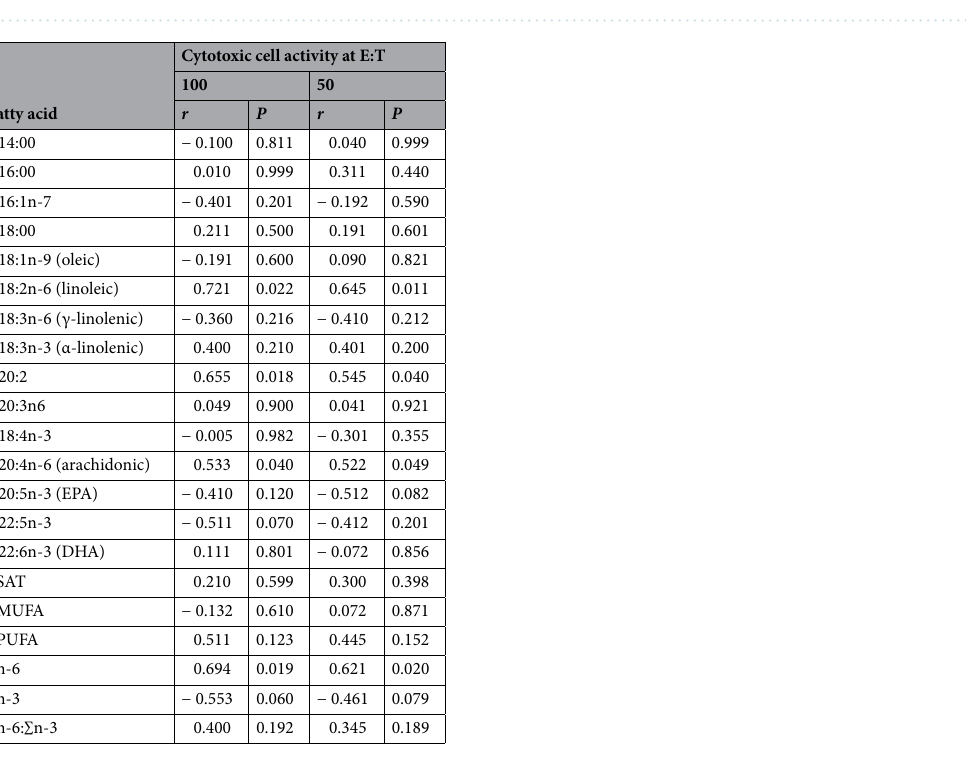
Table 6. Correlation coefficients for the relationships between % of individual fatty acids in the splenocytes and their cytotoxic cell activity. Correlation coefficient ( r ) is Spearman linear rank when data is not normally distributed or Pearson when data is normally distributed. EPA eicosapentaenoic acid, DHA docosahexaenoic acid, DPA docosapentaenoic